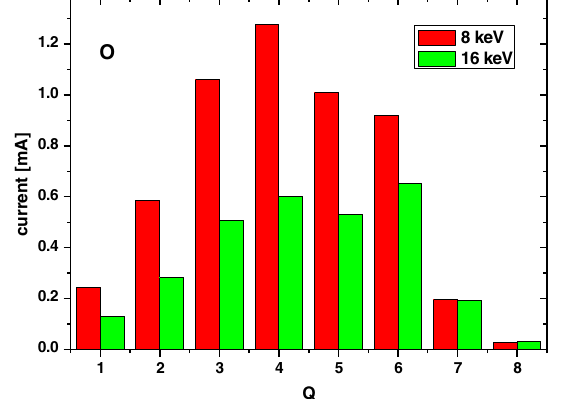
FIG. 2. Charge state distribution of the extracted oxygen ions for the electron temperatures of 8 and 16